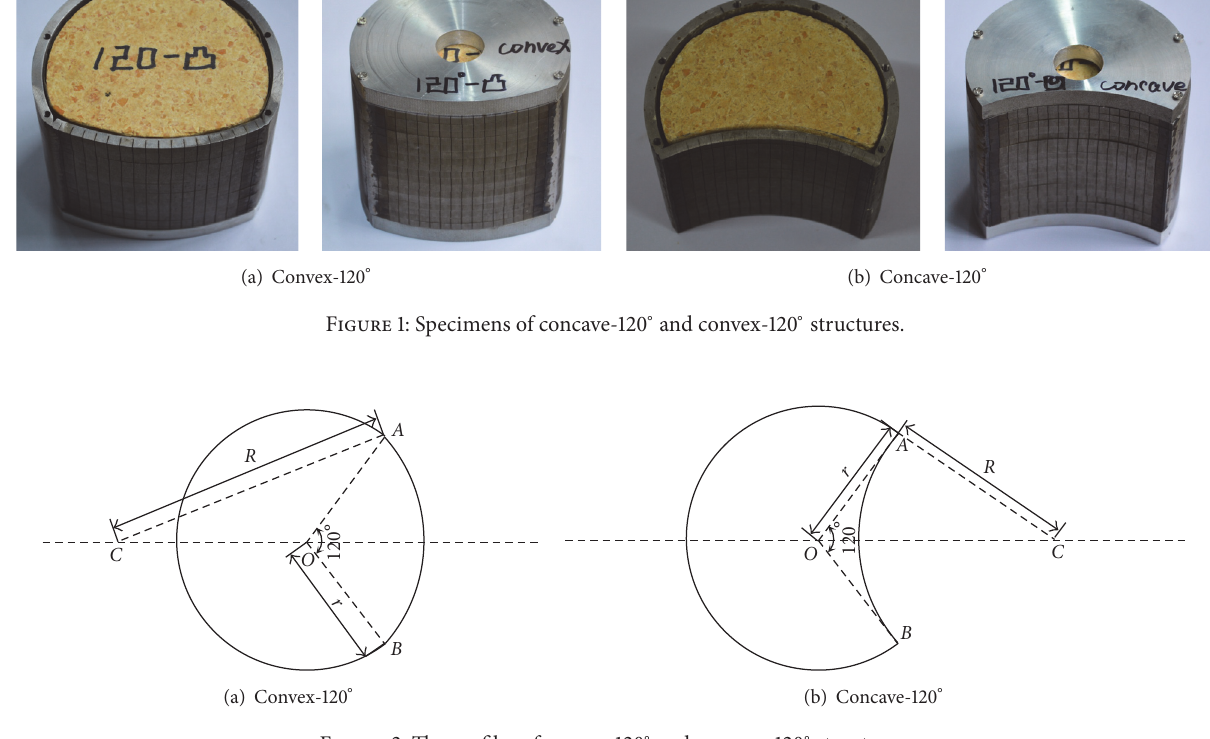
Figure 2: The profiles of convex-120 ∘ and concave-120 ∘ structures.